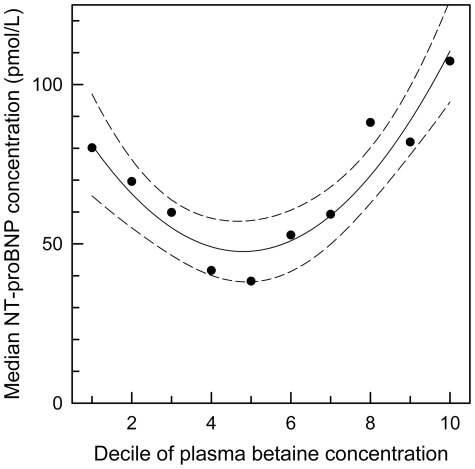
NT-proBNP and plasma betaine.Median NT-proBNP concentrations of deciles of gender-corrected plasma betaine concentrations; trend (quadratic regression) and 95% confidence intervals shown (p<0.001).